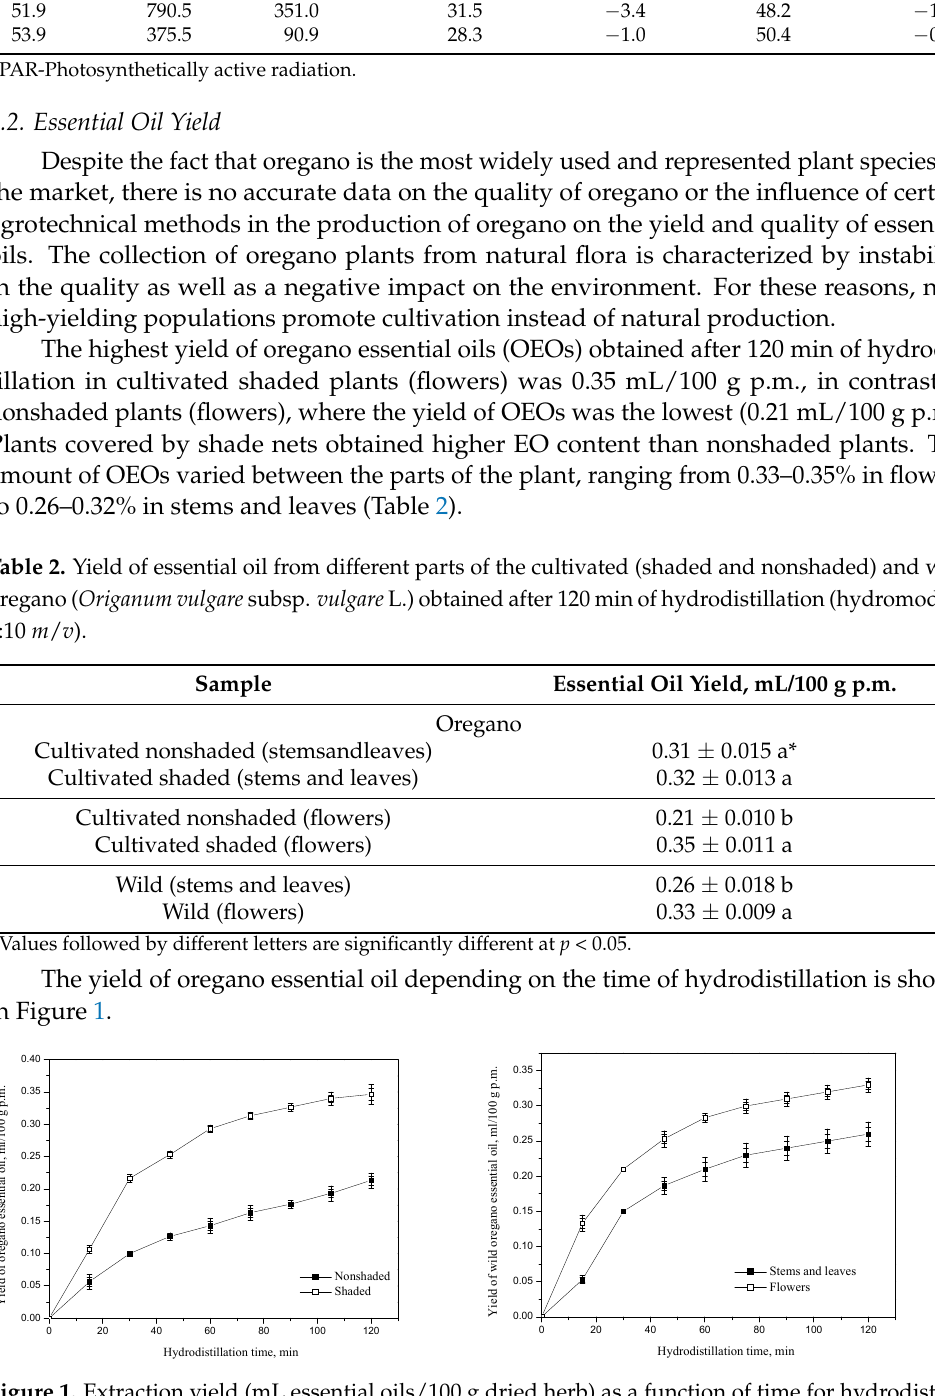
Figure 1. Extraction yield (mL essential oils/100 g dried herb) as a function of time for hydrodistilla- tion of essential oils from cultivated (shaded and nonshaded) and wild oregano plants. This study clearly showed that OEOs increased in all above-ground plant organs from shaded plants. The results from this study are in agreement with Ili ć et al. [16], who showed that the yield of essential oils (EOs) from shaded plants showed higher EO con- tent than nonshaded plants. The highest yields of essential oil from the Melissa officinalis L. are achieved when the plants are covered with blue nets [30], while red nets achieve the best effects in the production of basil [15]. It is similar in the production of thyme, mar- joram, and oregano, where the content of essential oils was higher in plants covered with pearl nets [17]. The content of essential oil compounds of European O. vulgare ranged between 0.03% and 4.6% [31]. In general, oregano as a species contains less EO (0.27–0.32%) than other medicinal plants from this family, so the yield of essential oils in oregano is much lower than that of thyme (2.32–2.57%) and marjoram (1.51–1.68%) [17]. An even smaller EOs production oforegano plants is recorded in lemon balm plants, where the content is quite low com- pared to other plants in the Lamiaceae family [16]. Regarding O. vulgare subsp. vulgare , all examined populations from Montenegro were rather poor in EO [1]. The highest OEOs yield was observed in the Mediterranean population(1.2%),while others had lower yields (0.7–0.9%). The populations of oregano in southern Albania had a higher amount of essential oil (3.45%) compared with those in the northern part (0.1%)[32]. The higher content of essential oil could be explained by the dryness, the thermal efficiency of the habitat, and as well as by the lower altitude [1]. The essential oil content of oregano from Iran showed a wide variability, ranging from 0.12% to 1.76% (v/w), correlating to the chemical profile [33]. The yield of the EOs from Iranian O . vulgare L. subsp. vulgare (thymol chemotype) was 0.5%, with a pale yellow color and a pungent odor [34]. Additionally, the concentration of oil depends on the population and the climatic conditions. The results of Goyal et al. [35] showed great variation in its EO content de- pending on geographical location and altitude of cultivation in India (Himalayan region). While EO yields in Origanum vulgare subsp. vulgare rarely exceeded 1% [36,37], they are usually greater than 2.5% [19] in Origanum syriacum from Turkey (2.9–3.5%), accord- ing to Arslan [38]. It is explained by the fact that O. vulgare subsp. vulgare has fewer gland hairs and is essential oil deficient [39]. Oregano essential oil content depends, among other things, on the plant part and the stage of plant development. According to Putievsky et al. [40], the essential oil content of